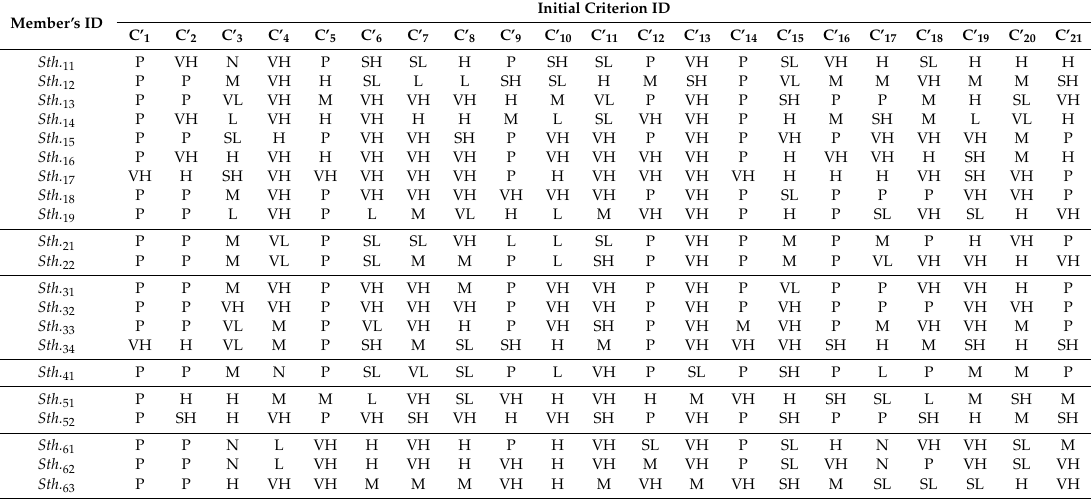
Table A4. The linguistic importance degrees of the initial criteria in the individual’s viewpoints.